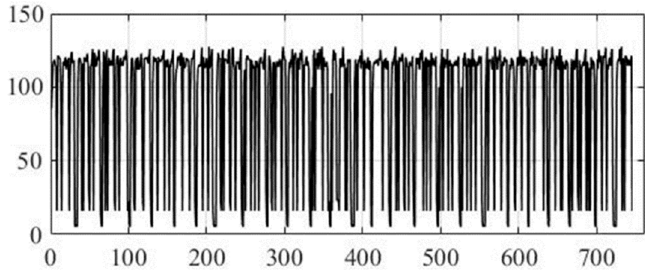
Table 1. The efficiency indicators of the stego-system based on the wavelet transform before the implementation of the developed method.